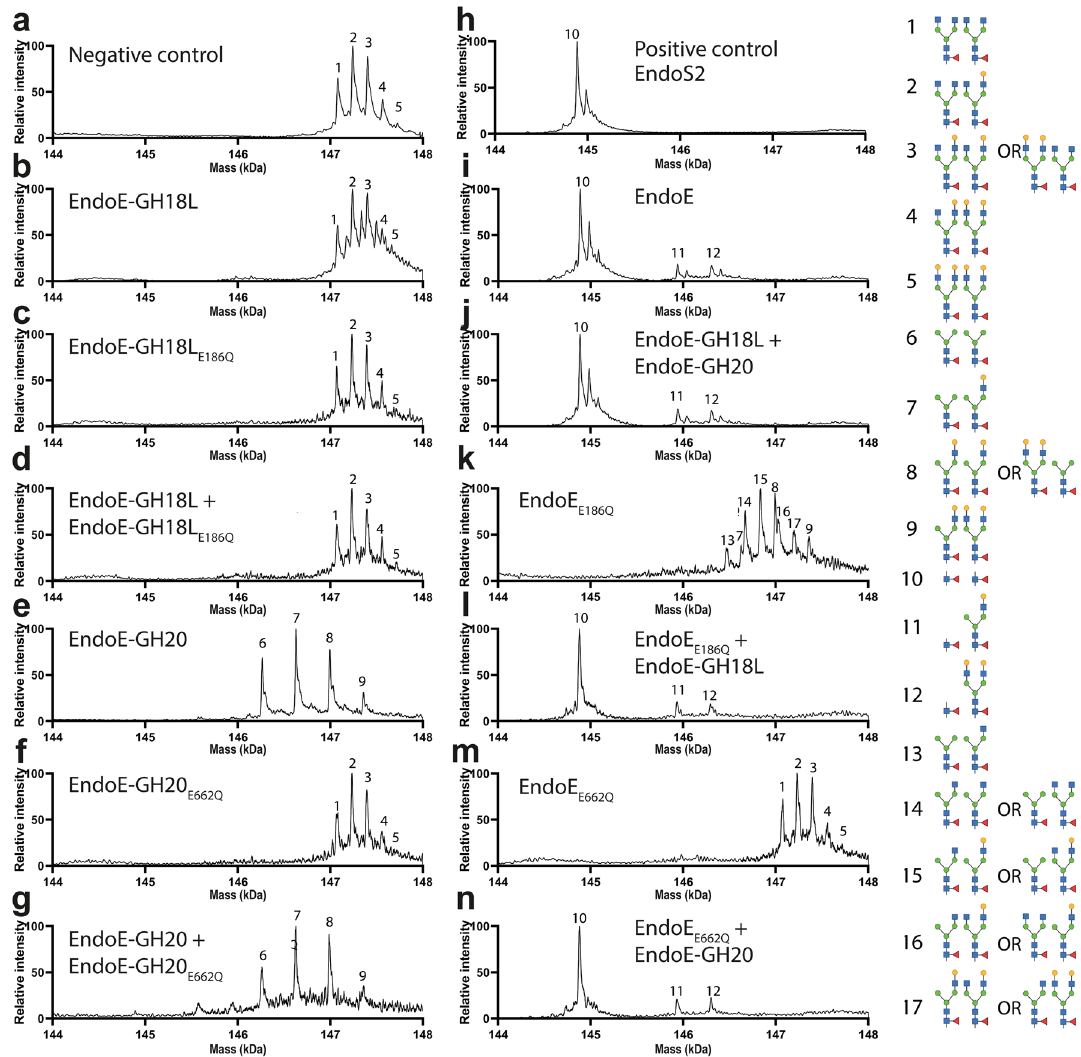
Fig. 5 Molecular basis of EndoE GH18 and GH20 domains substrate speci fi city as visualized by LC/MS. Processing of CT N -glycans on Rituximab. Mass spectrometry of Rituximab treated with a no enzyme (negative control) b EndoE-GH18L c EndoE-GH18L E186Q d EndoE-GH18L + EndoE-GH18L E186Q e EndoE-GH20 f EndoE-GH20 E662Q g EndoE-GH20 + EndoE-GH20 E662Q h EndoS2 (positive control) i EndoE j EndoE-GH18L + EndoE-GH20 k EndoE E186Q l EndoE E186Q + EndoE-GH18L m EndoE E662Q n EndoE E662Q + EndoE-GH20. The peaks corresponding to intact Rituximab are numbered based on the glycoforms found in each heavy chain. The retention time for Rituximab was 2.4 min. For mass deconvolution, the following parameters were used in